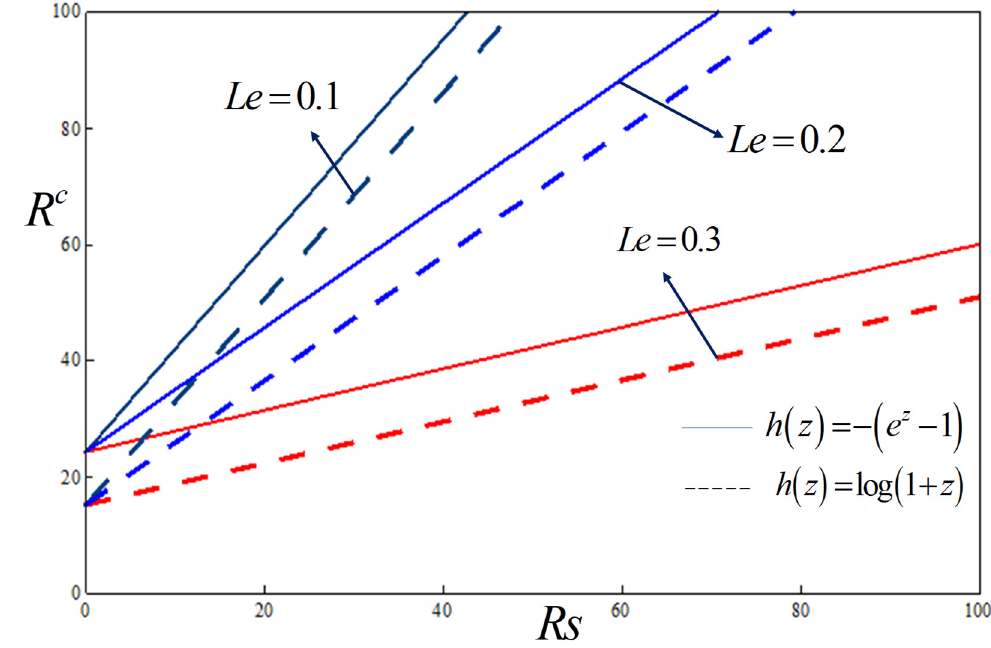
Figure 10. Plot of R c versus Rs for two types of variable gravity functions for various values of Le with Rs = 10, Da = 0.1, ξ = 0.5, η = 0.5 and δ =